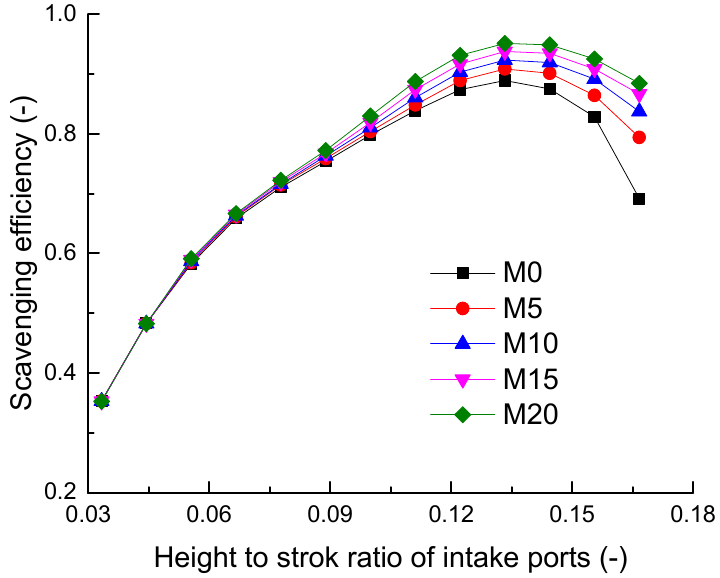
Figure 3. Scavenging efficiency for different height to stroke ratios of the intake ports.